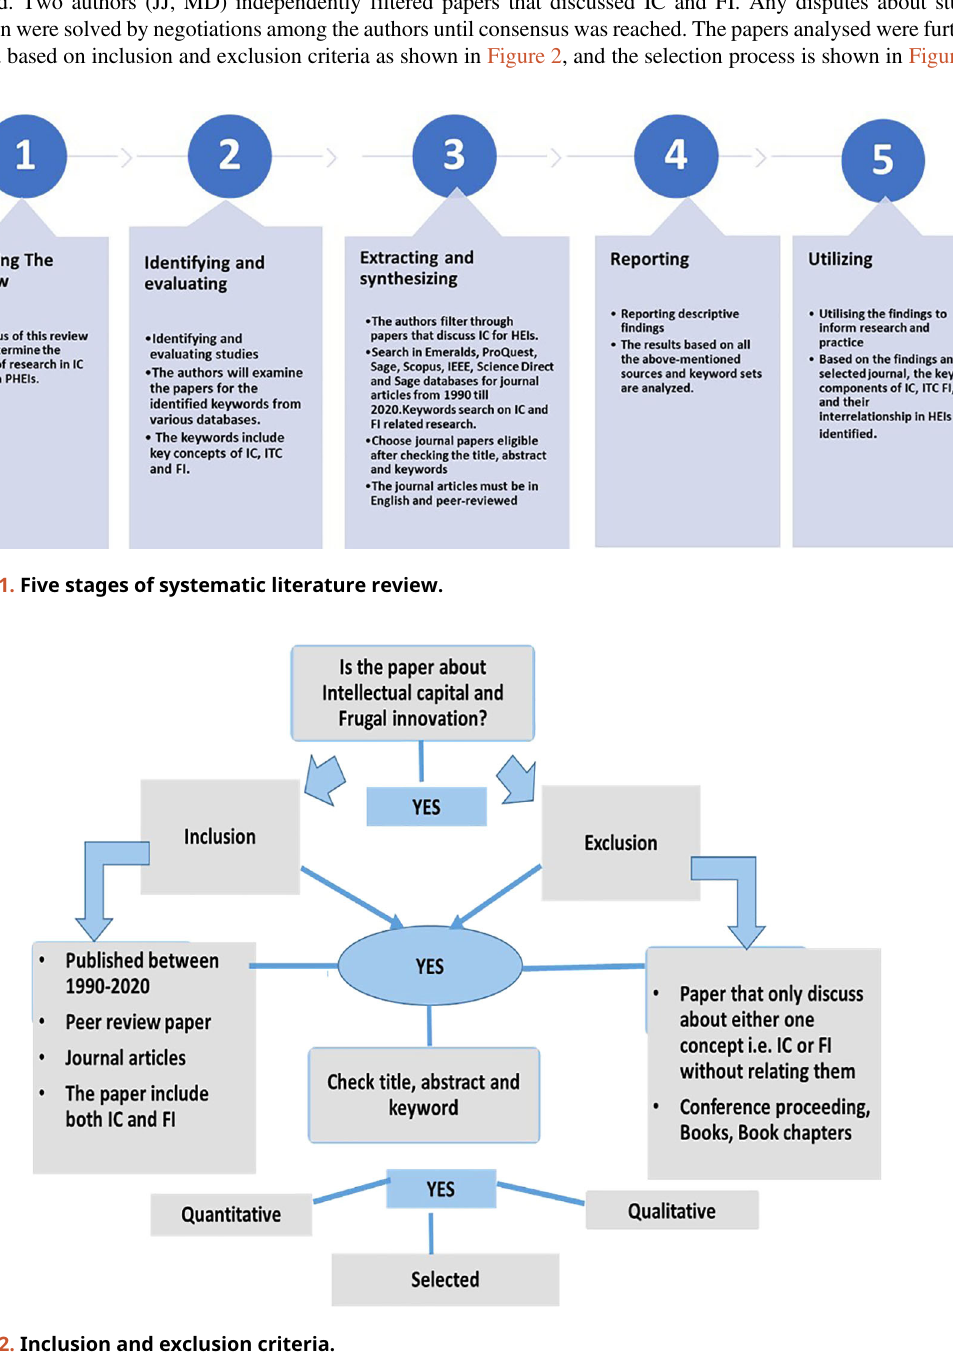
Figure 2. Inclusion and exclusion